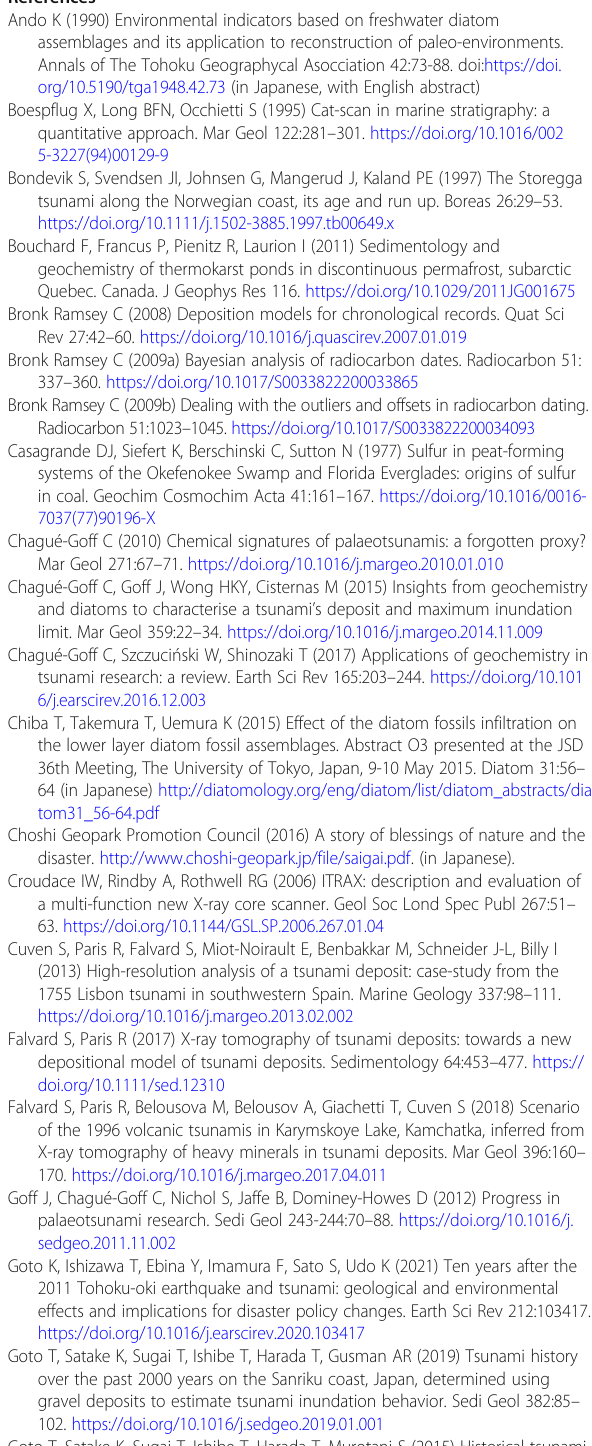
Additional file 1: Figure S1. CT image of Core KBT1 visualized by 3D Slicer, a free and open-source platform for analyzing and understanding medical image data. Figure S2. CT image of Core KBT2 visualized by 3D Slicer, a free and open-source platform for analyzing and understanding medical image data. Figure S3. CT image of Core KBT4 visualized by 3D Slicer, a free and open-source platform for analyzing and understanding medical image data. Domain outlined by the white rectangle shows that the sampling area for grain size analyses (214 – 241 cm depth). Figure S4. CT image of Core KBT6 visualized by 3D Slicer, a free and open-source platform for analyzing and understanding medical image data. Figure S5. CT image of Core KBT8 visualized by 3D Slicer, a free and open- source platform for analyzing and understanding medical image data. Figure S6. CT image of Core KBT10 visualized by 3D Slicer, a free and open-source platform for analyzing and understanding medical image data. Figure S7. CT image of Core KBT11 visualized by 3D Slicer, a free and open-source platform for analyzing and understanding medical image data. Figure S8. CT image of Core P-14 visualized by 3D Slicer, a free and open-source platform for analyzing and understanding medical image data. Figure S9. Grain size distribution of Core KBT4 (214 – 217 cm depth). Figure S10. Grain size distribution of Core KBT4 (217 – 229 cm depth). Figure S11. Grain size distribution of Core KBT4 (229 – 241 cm depth). Table S1. Result of diatom assemblage